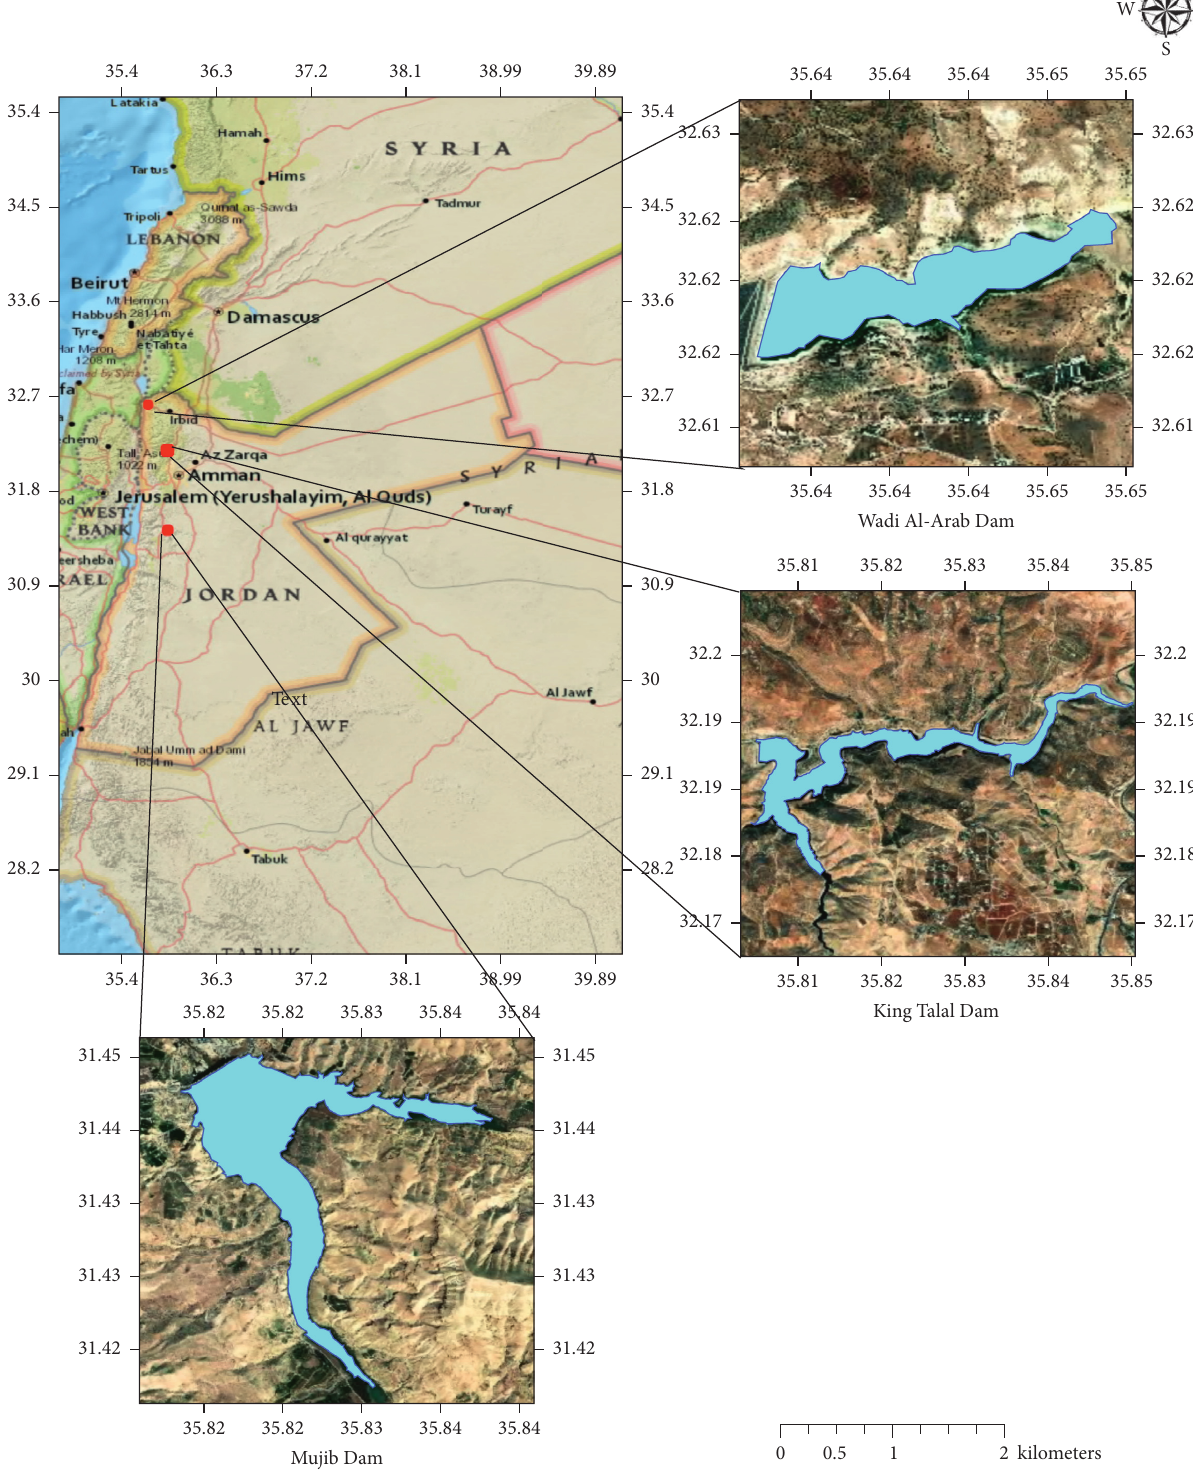
Figure 1: Jordan’s map with selected dams’